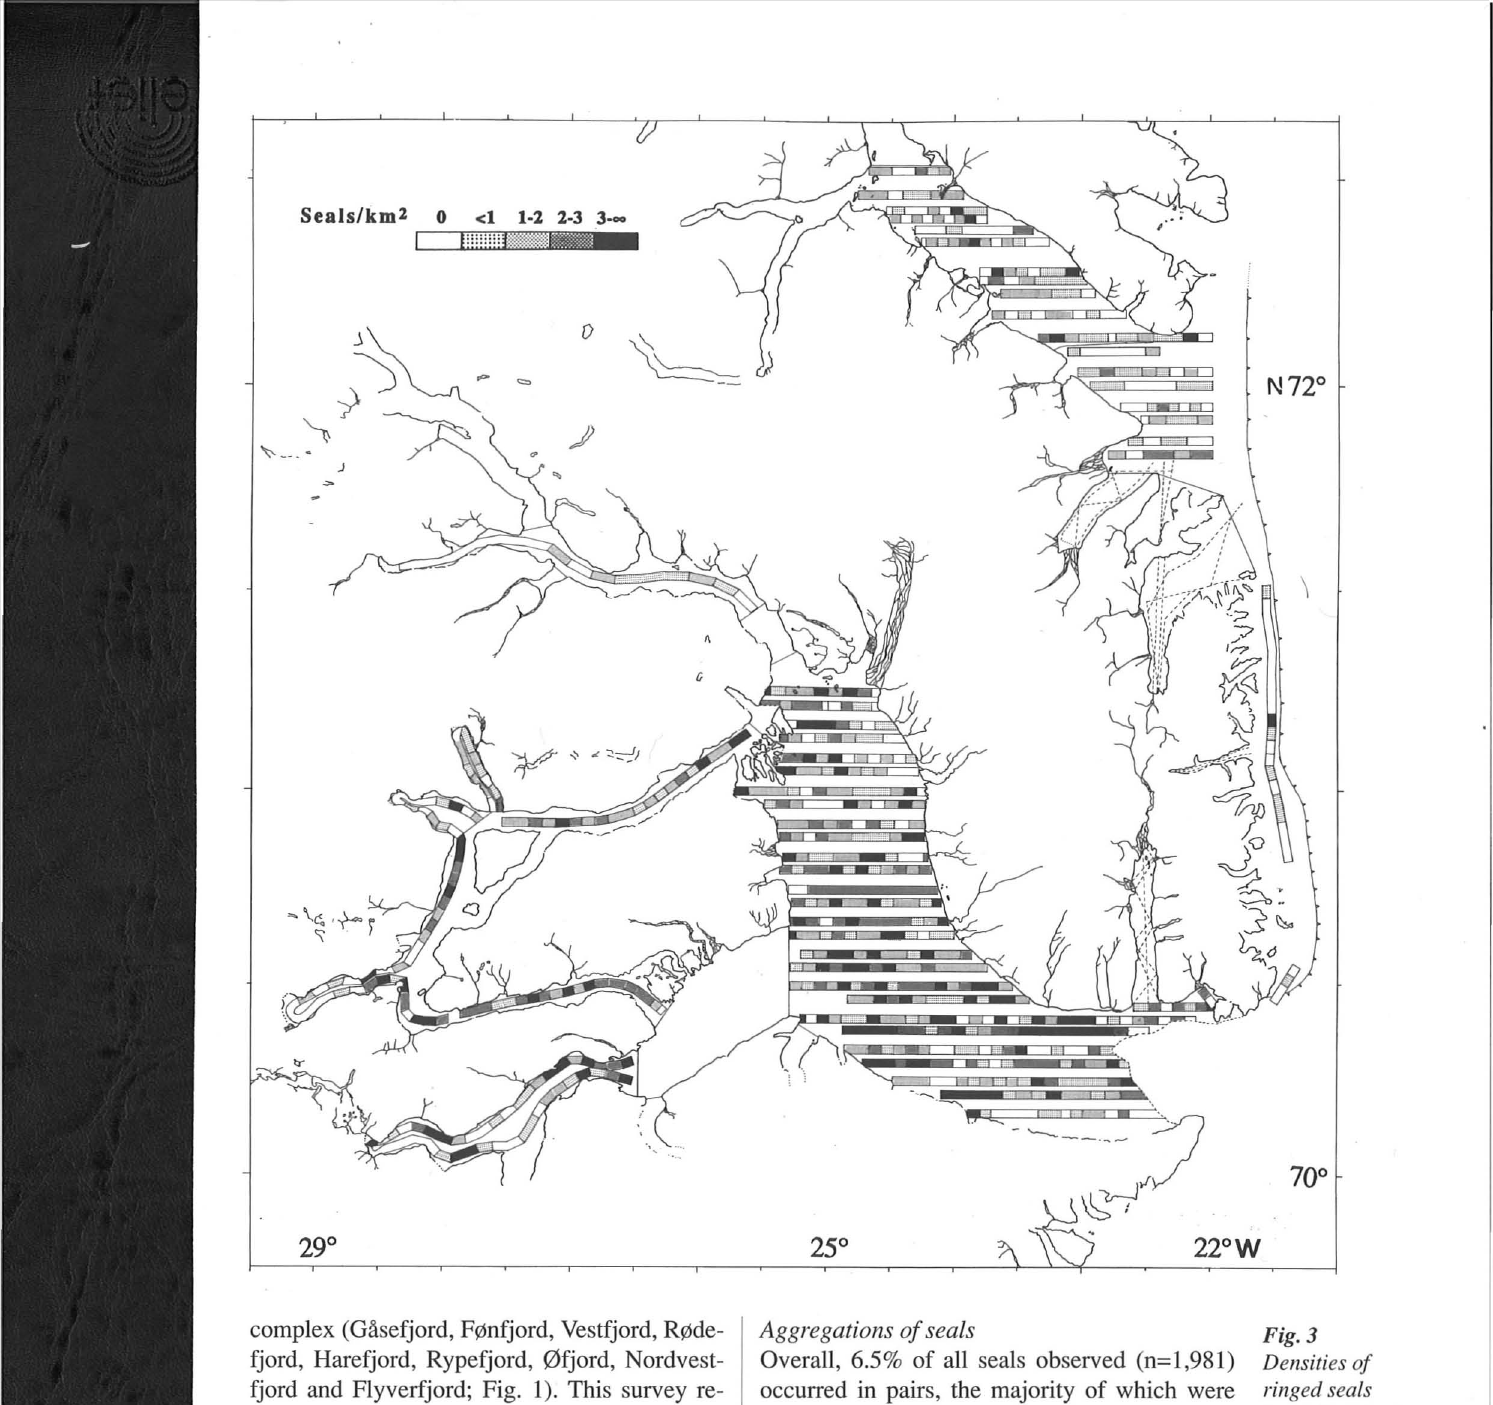
Fig. 3 Densities of ringed seals (sealstkm') in the Kong Oscars FjordlDavy SUlld, Scoresby Sundt Hall Bredning and adjacent ar eas obtained dur ing aerial surveys conducted